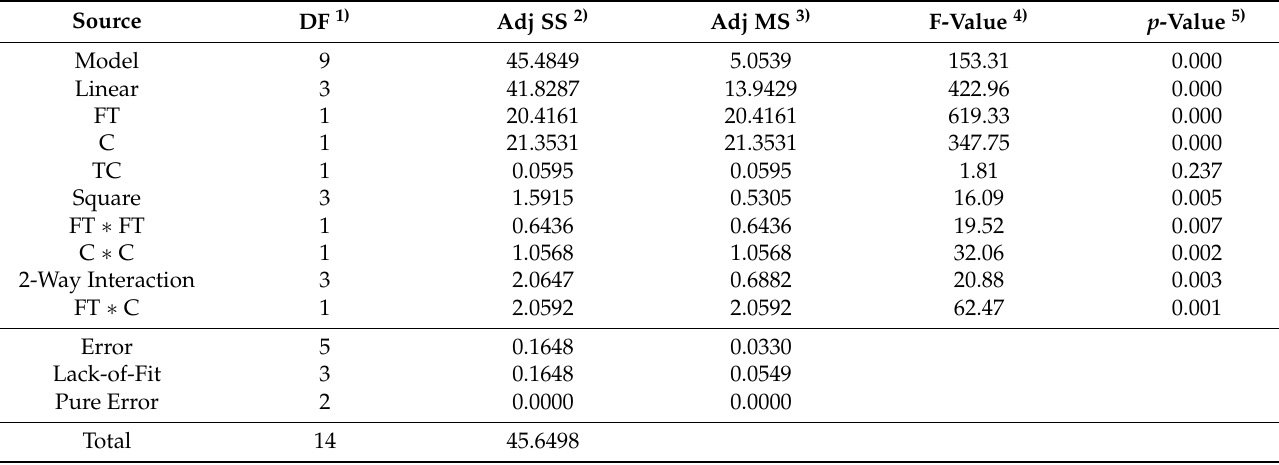
Table 7. Response surface analysis results for three